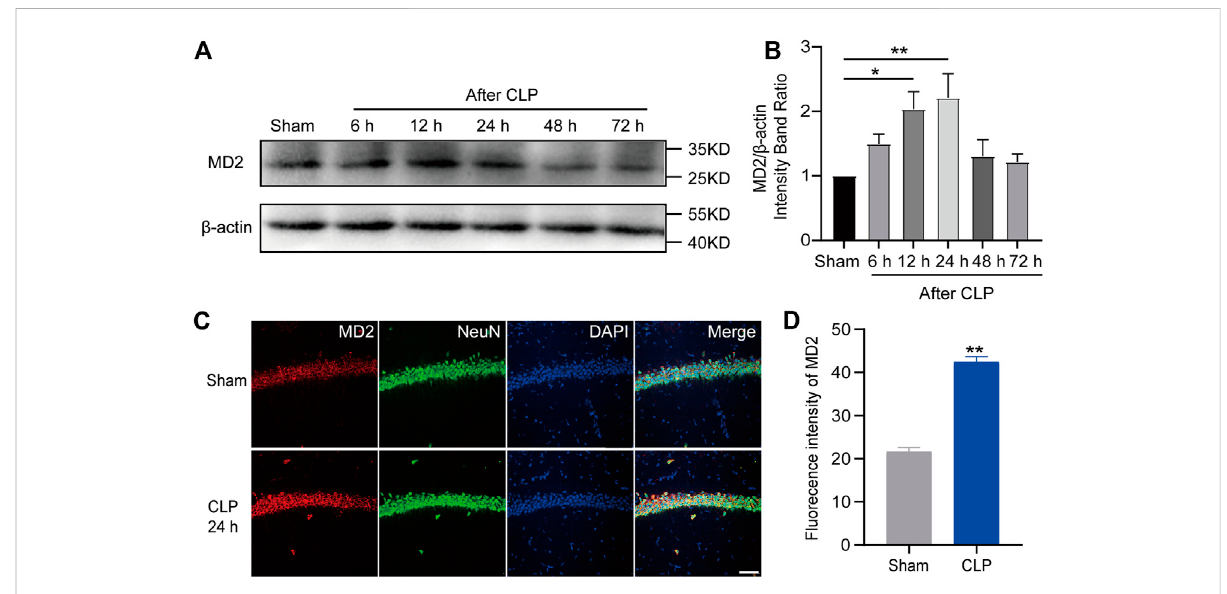
FIGURE 4 MD2 was increased in hippocampal neurons in septic mice. (A) . Representative Western blot of MD2. (B) . Quantitative evaluation of MD2 expression after CLP atthe time point. ** p < 0.01 vs. thesham. Data are shown as the mean ± SEM ( n = 9). (C) . IF staining of MD224 hafter CLP (bar = 40 μ m). (D) . Analysis of the intensity of MD2 between the sham and CLP. ** p < 0.01 vs. the sham. Data are shown as the mean ± SEM ( n =